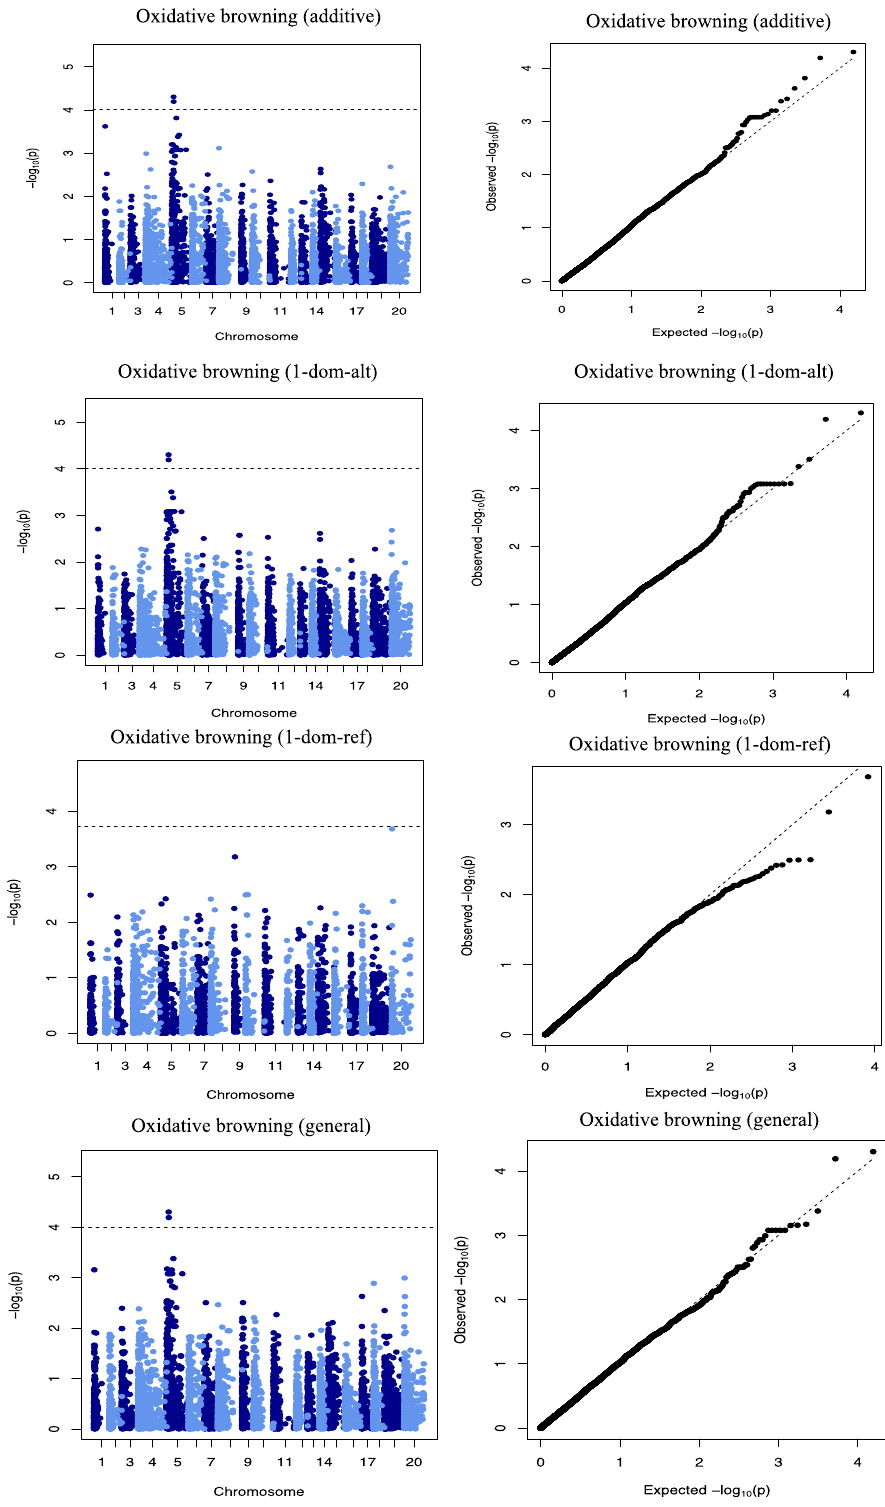
Figure 5. Genome-wide association analysis for OxB. Manhattan and Quantile–quantile plots for OxB on chromosome 5. The dashed lines on the Manhattan plot represent a significant threshold.